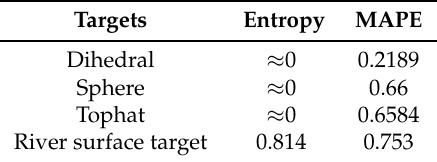
Table 2. Multi-aperture polarimetric entropy (MAPE) and the polarimetric entropy of typical